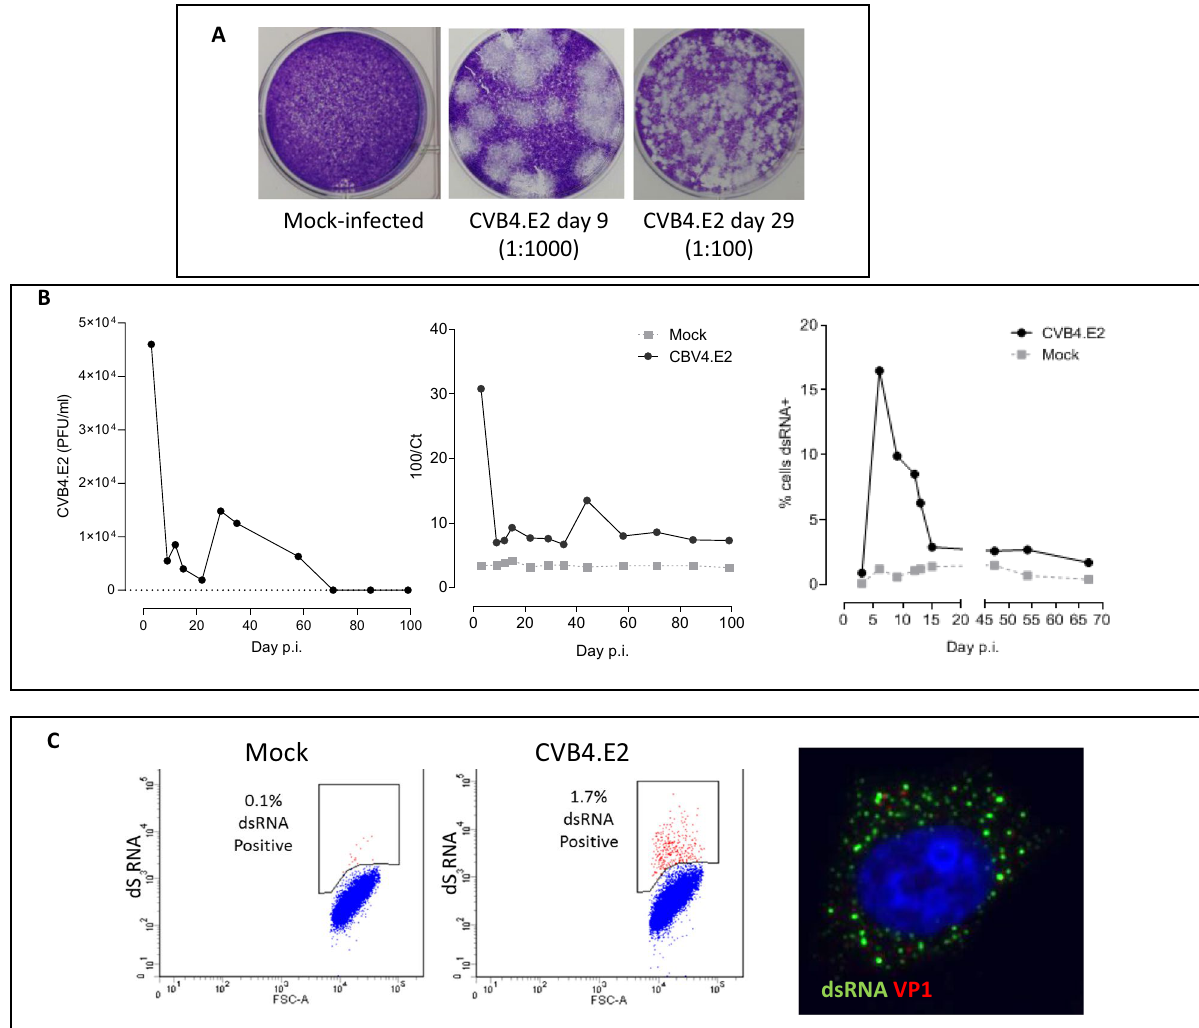
Figure 1. Progression of enteroviral infection in 1.1B4 cells exposed to Coxsackie B4.E2. ( A ) Cell culture medium collected from 1.1B4 cells was utilised in virus infectivity assays with HEp-2 cells. Viral plaques were examined after plating of culture medium (diluted as shown) that had been collected from mock infected cells (left panel) or from cells on either day 9 (middle plate) or day 29 (right plate) post-infection and incubated on lawns of HEp-2 cells. Representative results from an individual experiment are presented. ( B ) One Step qRT-PCR was performed with CBV4-specific primers using RNA harvested from culture medium of CVB4. E2 or mock infected 1.1B4 cells. Representative results from an individual experimental run are shown and are presented as relative Ct values (middle panel) in comparison with quantified plaque forming units of virus (left panel). The percentage of dsRNA positive (virally-infected) cells at each time point is shown in the right panel. ( C ) A representative example of CBV4.E2 or mock infected cells stained using an antibody raised against dsRNA and assessed by flow cytometry at day 64 post infection. The right panel illustrates cells immunostained to detect VP1 and dsRNA (imaged on day 12 post